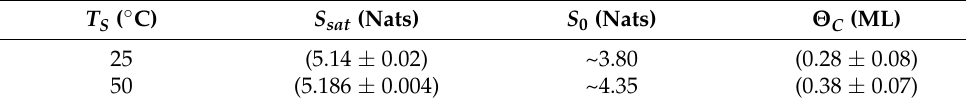
Table 1. Data extracted from exponential plateau fitting by using Equation